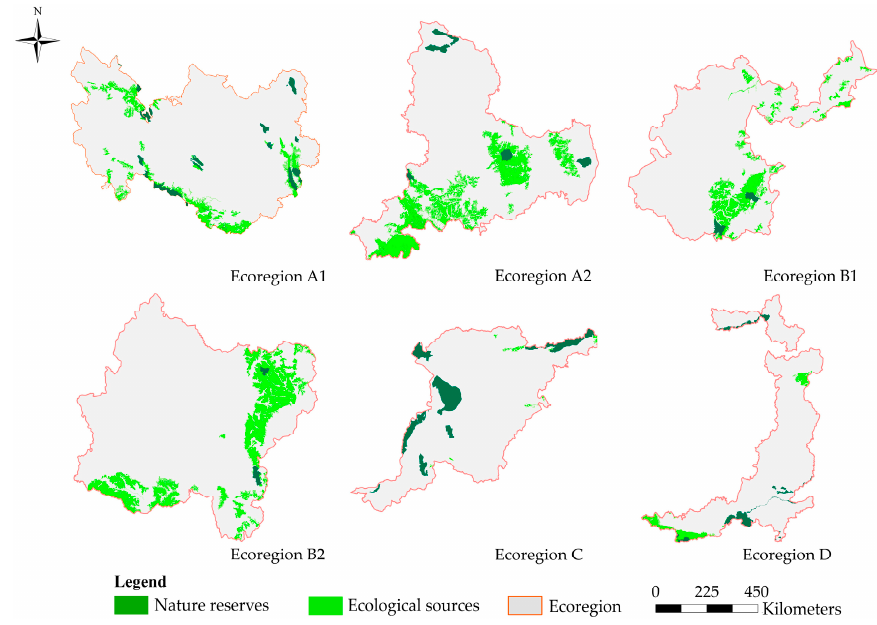
Figure 6. Spatial distribution of ecological sources in each ecoregion.